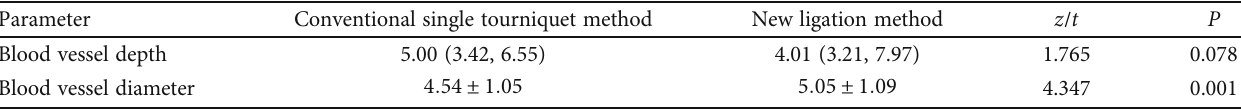
Figure 2: Ultrasound detection on the e ff ect of two ligation methods on vessel depth and diameter. (a) Images of vascular depth and diameter measured by conventional methods; (b) images of vessel depth and diameter measured by the new ligation method. Table 1: Comparison of vessel depth and vessel diameter between two tourniquet fastening methods.